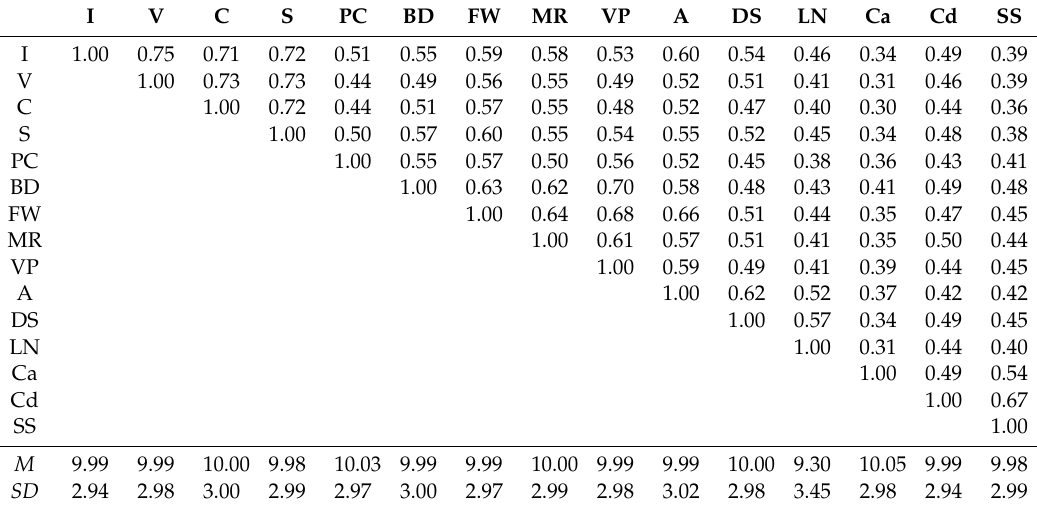
Table 1. Correlation matrix and descriptive statistics of Hungarian Wechsler Adult Intelligence Scale Fourth Edition